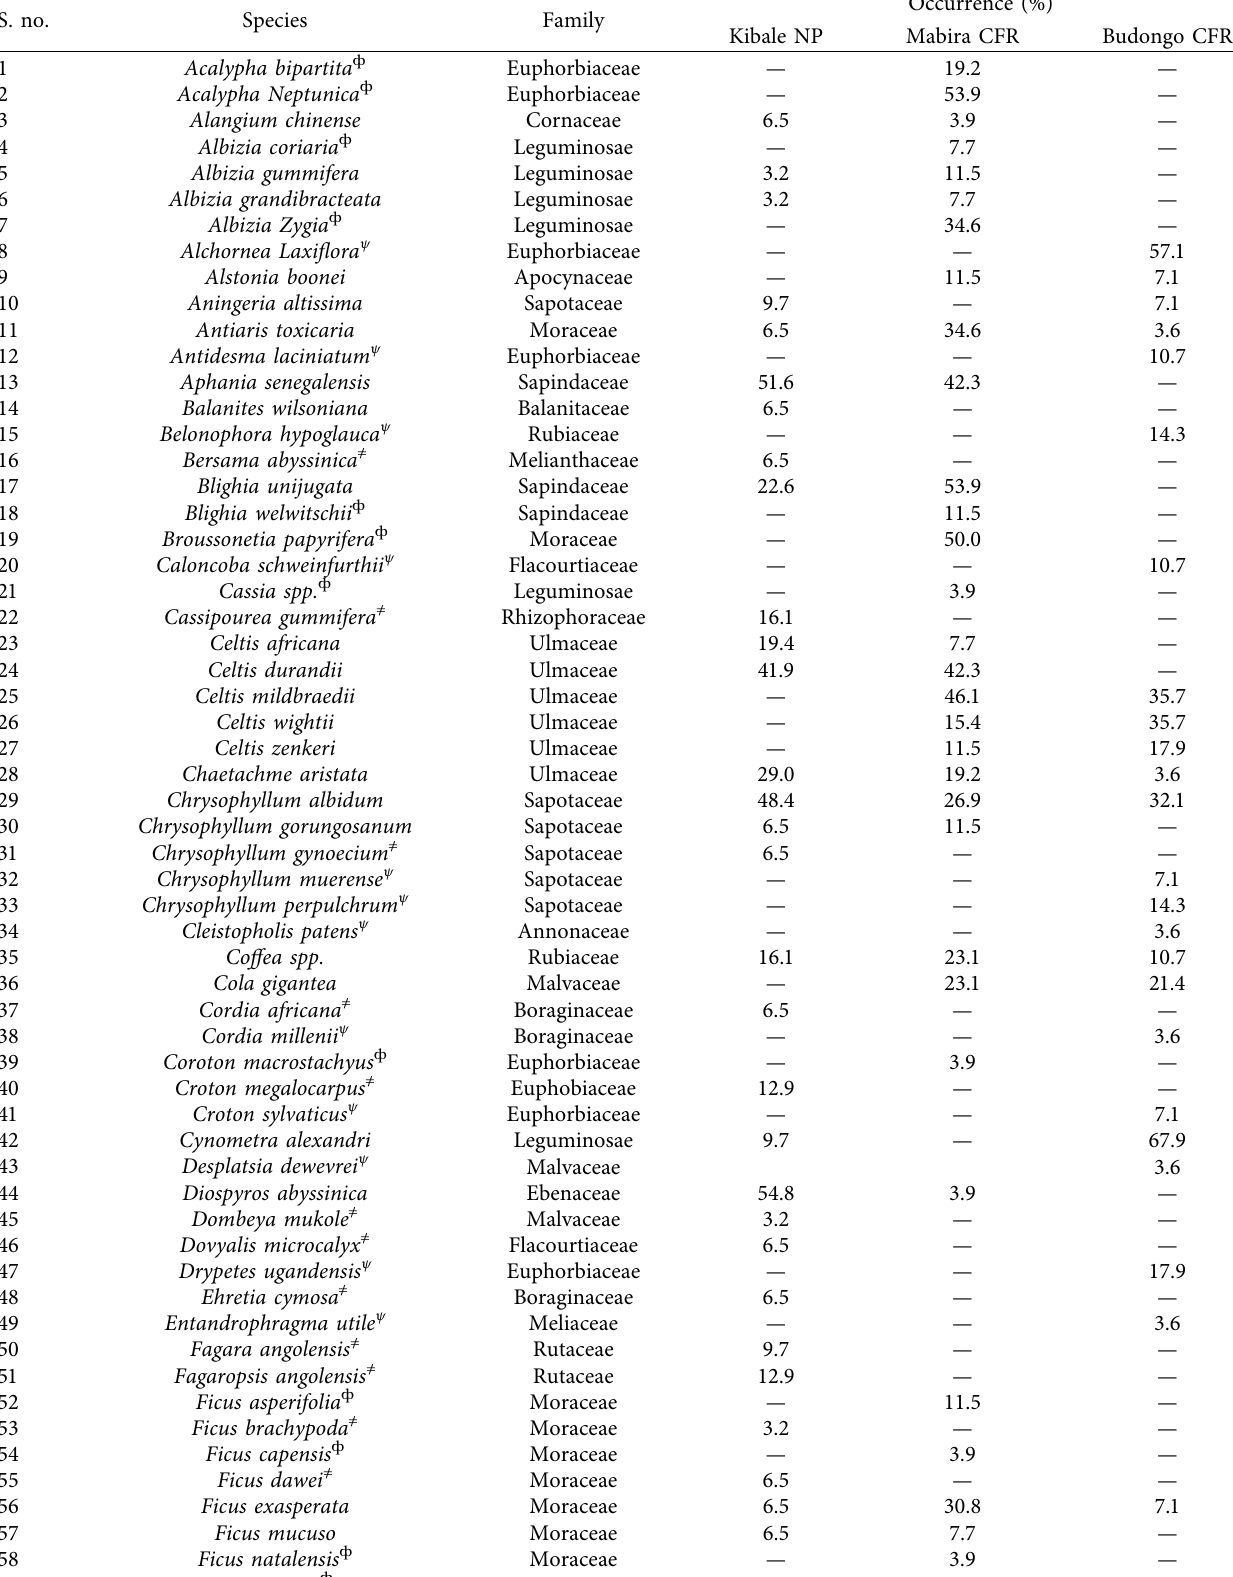
Table 2: Plant species assemblages cooccurring with C. articulata